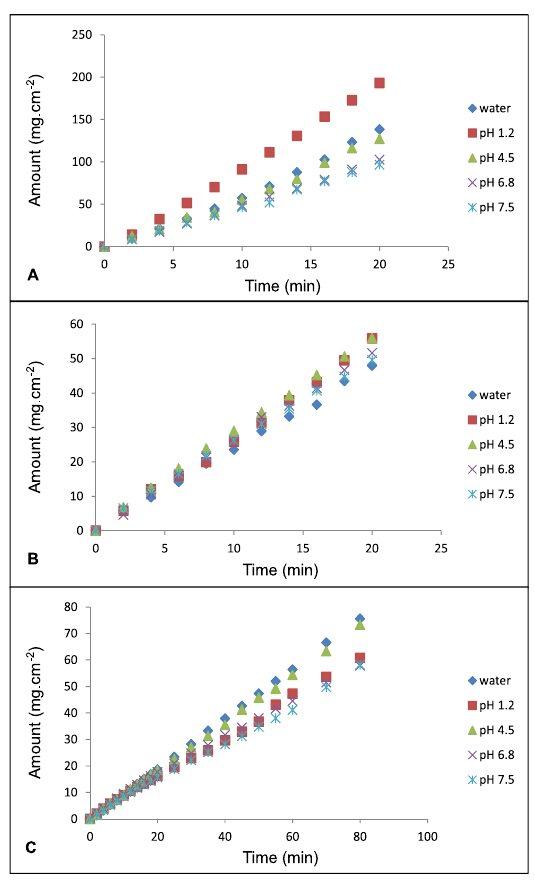
FIGURE 2 - Amount versus time profile for 3TC (A), d4T (B) and AZT (C) at pH values of 1.2, 4.5, 6.8, 7.5 and